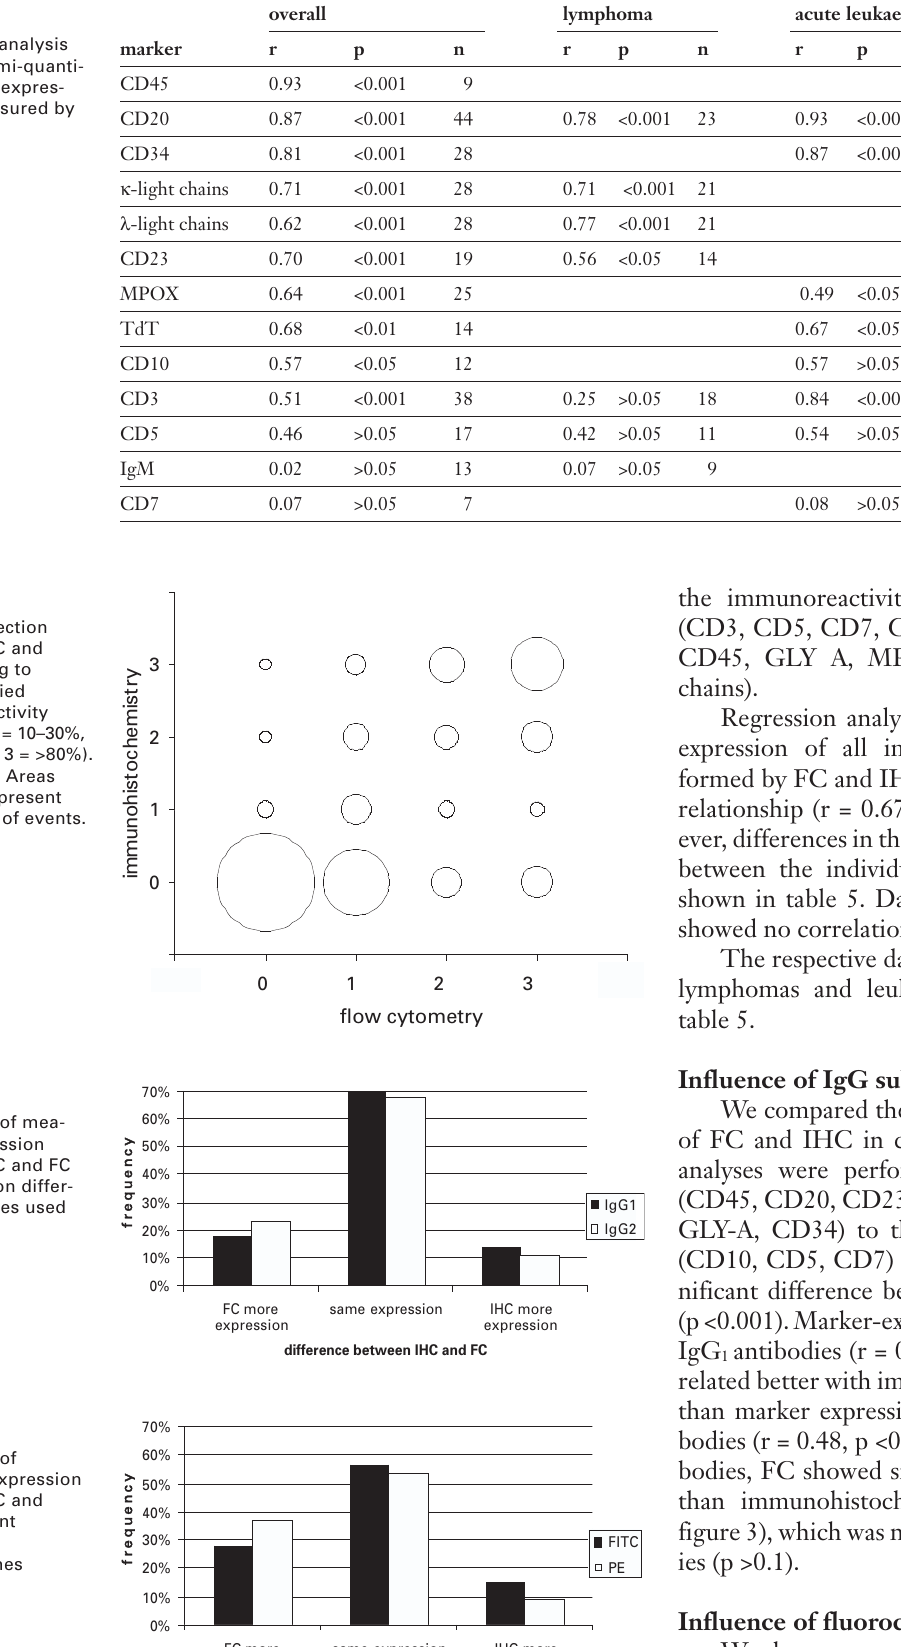
Differences of measured expression between IHC and FC dependent on different fluorochromes used for FC.